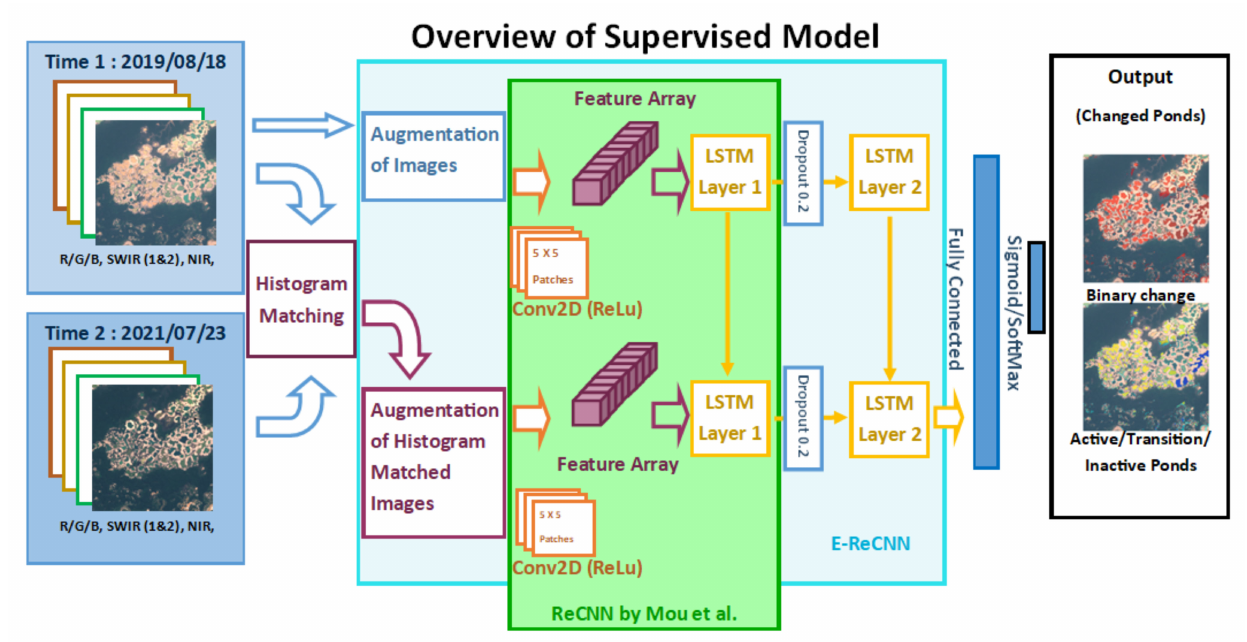
Figure 4. The E-ReCNN model uses two cloud-free Sentinel 2B images obtained from two different times (18 August 2019 and 23 July 2021) for the same region. Following histogram matching and augmentation, we used a convolutional kernel (Conv2d) on 5 × 5-pixel patches across each image to generate a feature array. These feature arrays then served as the input of the first LSTM layer, and the second LSTM layer was formed following a dropout of 0.2. The last two layers were fully connected, and an output layer was applied with sigmoid/softmax functions to recognize the change in the pond’s